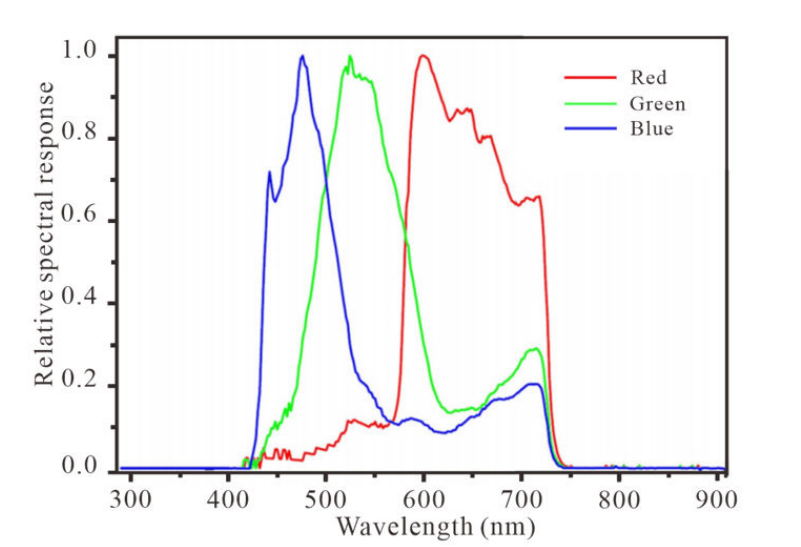
Figure 5. The RGB relative spectral response of JL1-3B. Table 3. The JL1-3B parameters for converting DN to radiance (W / m -2 / sr − 1 ).